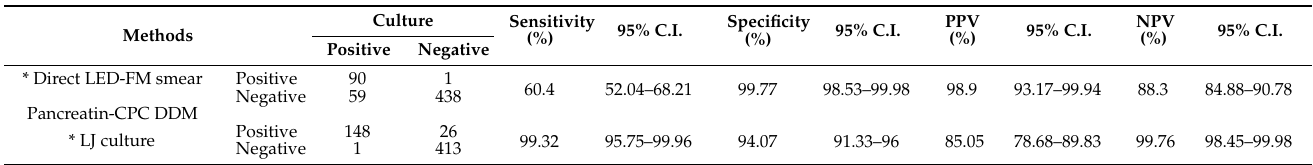
Table 5. Diagnostic accuracy of direct microscopy and culture for detection of Mycobacterium tuberculosis (MTB) and non-tuberculous Mycobacteria (NTM) after treatment with NALC-NaOH and pancreatin-CPC